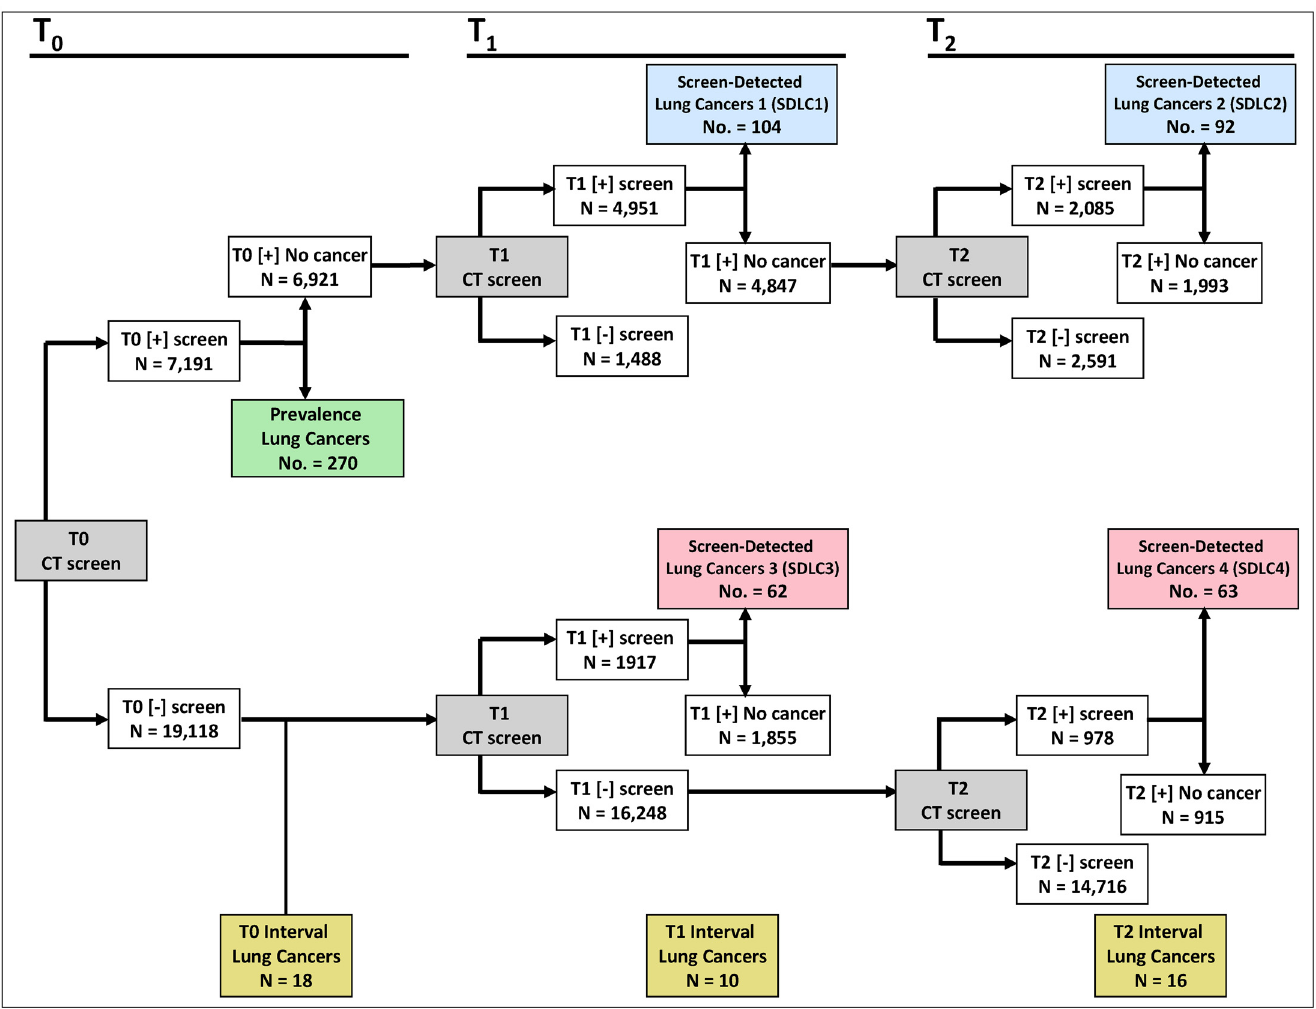
Fig 1. Schema for the lung cancer case cohorts in the NLST at prevalence (baseline) and incidence screening (follow-up) rounds. Abbreviations: T0 = baseline screen; T1 = first screen; T2 = second screen; [+] = positive screen; [ – ] = negative screen. Prevalence lung cancers diagnosed at T0 are shaded green. Screen-detected lung cancers diagnosed at T1 and T2 rounds in which T0 screens were positive are shaded blue. Screen-detected lung cancers diagnosed at T1 and T2 in which T0 screens were negative are shaded red. Interval cancers (beige boxes) were diagnosed following a negative screen. Participants were excluded if their screening results were inadequate or not compliant. At baseline we excluded 413 screens, 1,471 screens at T1, and 713 screens at T2.